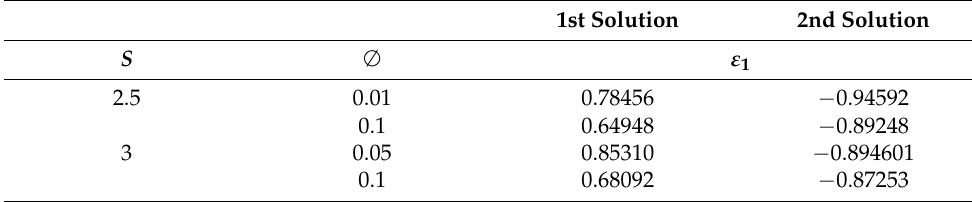
Table 4. Smallest eigenvalues for different values of 𝑆 and ∅ .